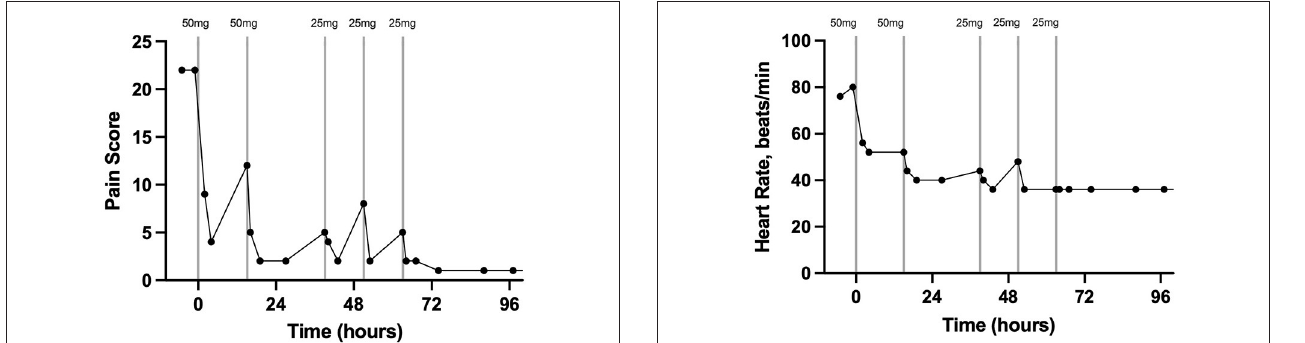
FIGURE 1 | Pain scoring 2h prior to, during, and after treatment with morphine via a C1-C2 epidural catheter in a horse. The vertical lines indicate the timing and dose of morphine administration. Each data point represents a pain score. Time zero is the time of C1-C2 catheter placement and first morphine dose.